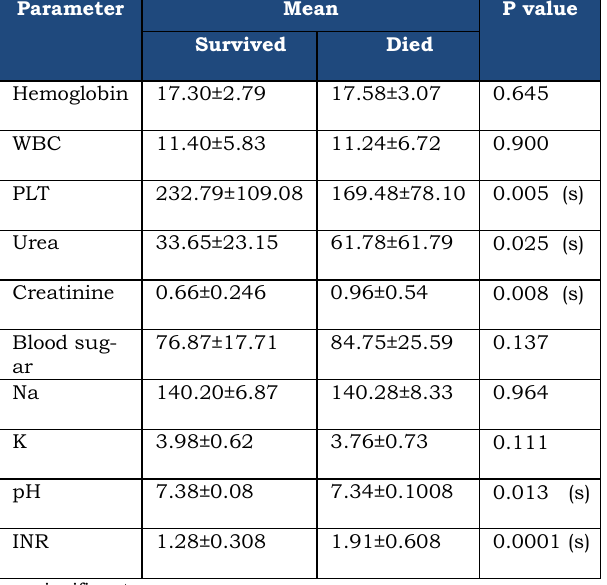
Table 3: Univariate analysis (difference of means) of lab values at admission.